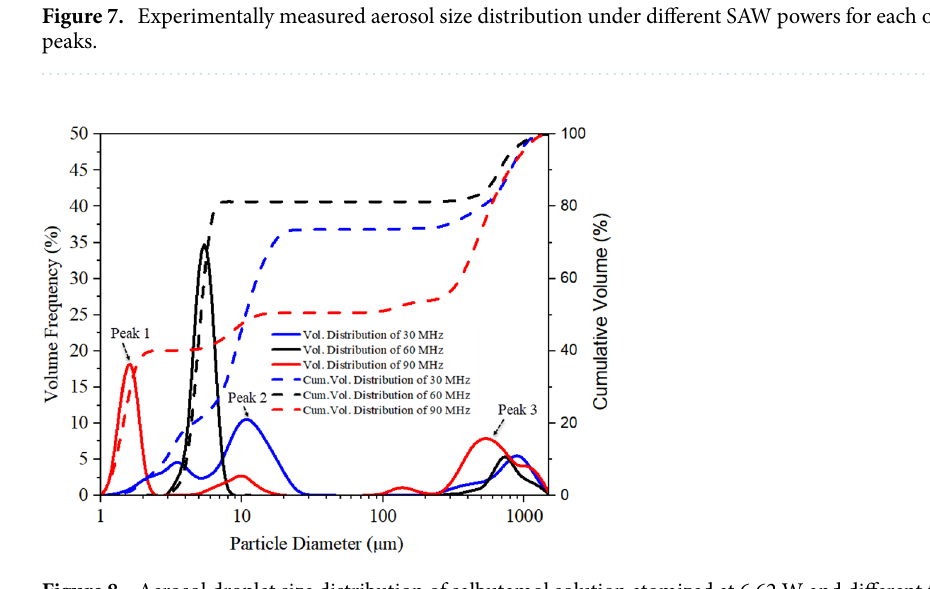
Figure 8. Aerosol droplet size distribution of salbutamol solution atomized at 6.62 W and different frequencies, measured by laser diffractometry. Each frequency value was tested three times and then the results were averaged. Note that the mean diameters D v50 for the three analysed frequencies were 10.66 μm, 5.13 μm, and 3.02 μm, respectively, and the the standard deviation were 1.298, 1.584, and 0.889,